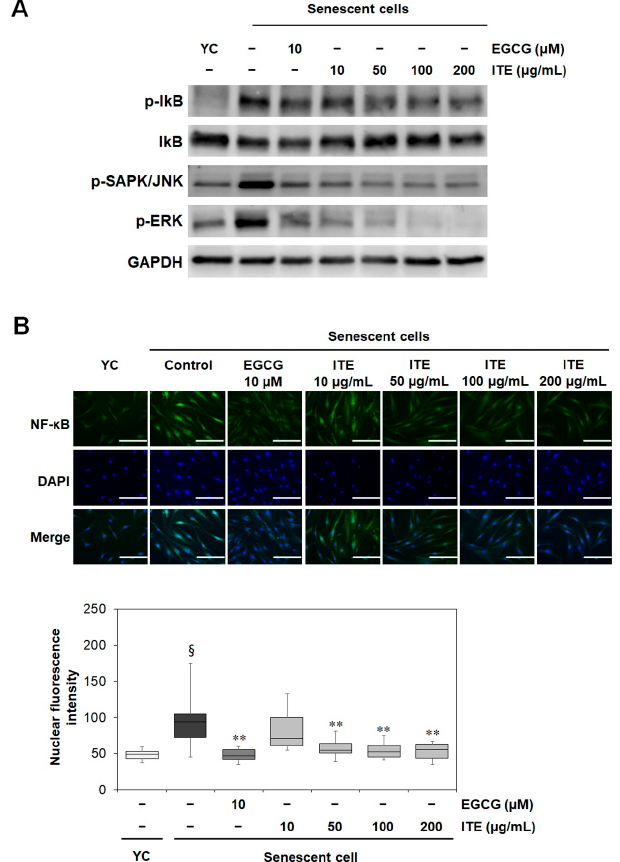
Figure 4. Inhibitory effect of ITE on the expression of I κ B α , JNK, and ERK and NF-kB translocation to the nucleus in RS-HDFs. ( A ) Western blot was used to determine the protein expression levels. Each of the figures is representative of 3 independent experiments. GAPDH was used as a control to confirm equal protein loading. ( B ) Representative immunofluorescence image and nuclear fluorescence intensity analysis. Cells were stained with antibodies to p65 (green) and 4 ′ ,6-diamidino-2- phenylindole (DAPI; blue) and captured at ×200. The data are presented as the mean ± SEM of three independent assays. § p < 0.01 compared to young HDF controls, ** p < 0.01 compared to RS-HDF controls. YC, young cell controls.